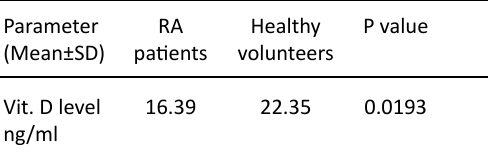
Table 1. Baseline characteristics of 25-OH Vit. D for RA patients and healthy